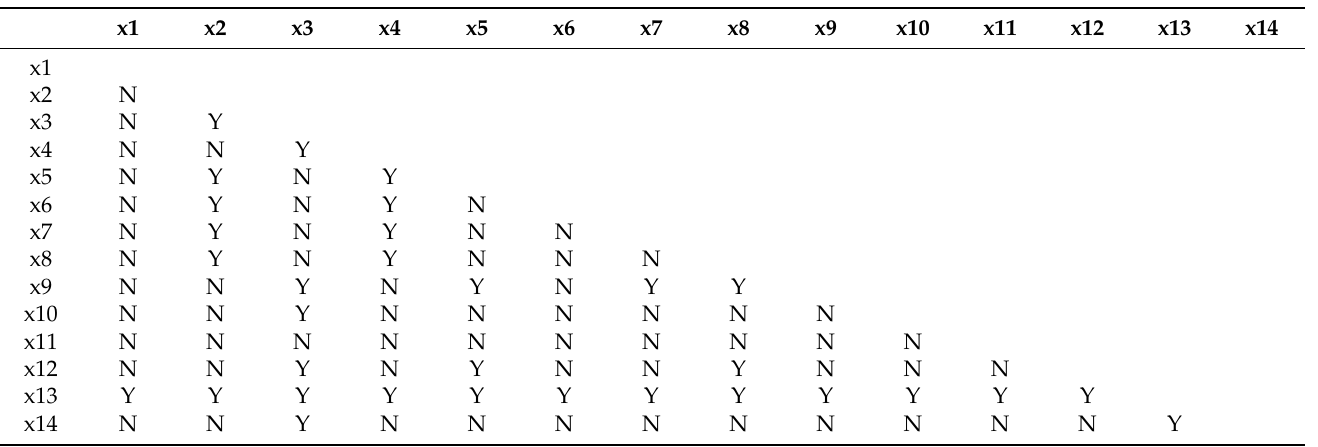
Table 5. Ecological detection results (95% confidence